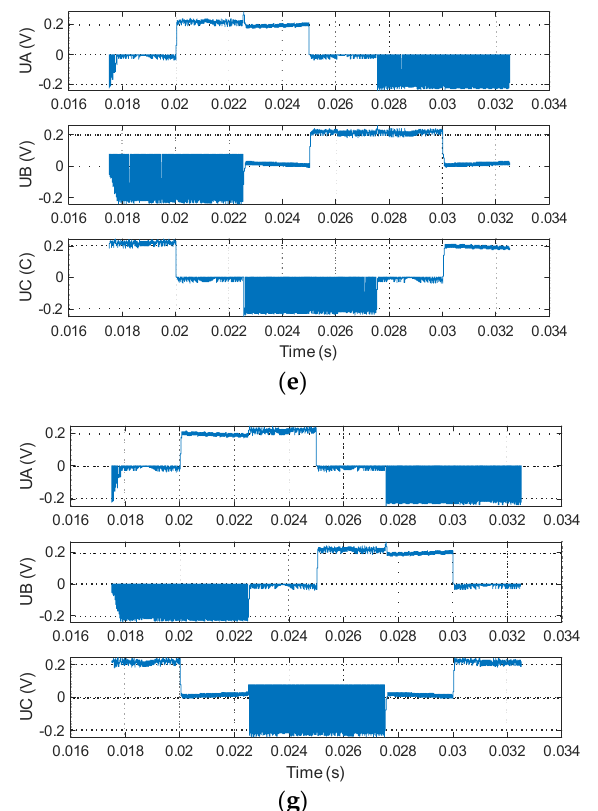
Figure 2. Voltage waveforms of shunt resistors. ( a ) Normal condition; ( b ) abnormal condition in S AH ; ( c ) abnormal condition in S AL ; ( d ) abnormal condition in S BH ; ( e ) abnormal condition in S BL ; ( f ) abnormal condition in S CH ; ( g ) abnormal condition in S CL